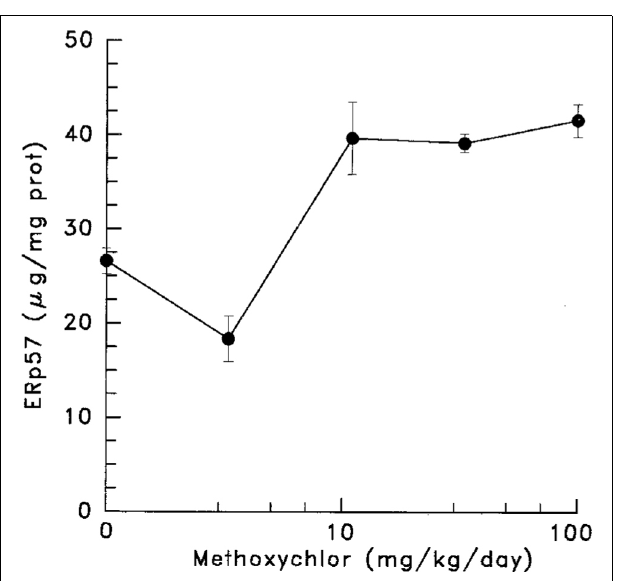
FIGURE 12 |The effect of feeding of methoxychlor for 3 weeks on the hepatic level of ERp57 (data taken from Morrell etal., 2000).